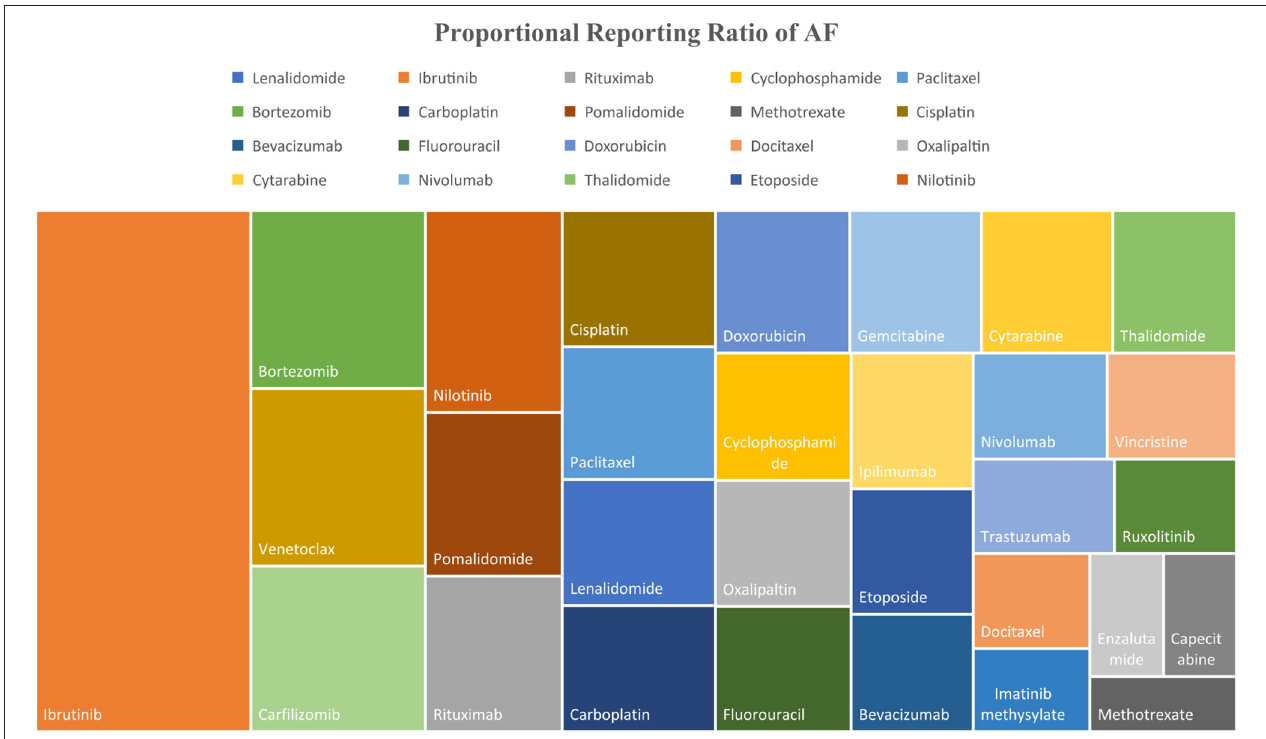
FIGURE 5 | Tree map showing the PRR of AF for top 30 anti-cancer drugs included in the